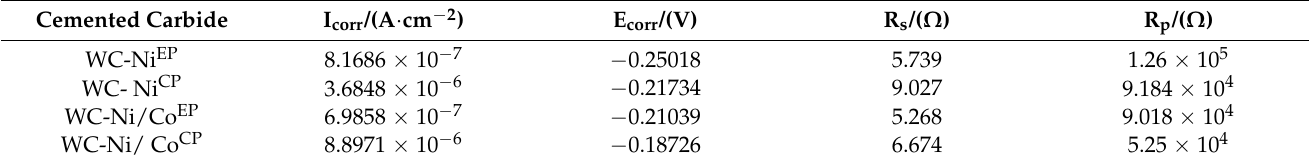
Figure 6. Polarization curves of cemented carbide samples: ( a ) WC-Ni EP and WC-Ni CP ; ( b ) WC- Ni/Co EP and WC-Ni/Co CP . Table 5. Electrochemical and fitting circuit parameters of cemented carbide in simulated seawater.